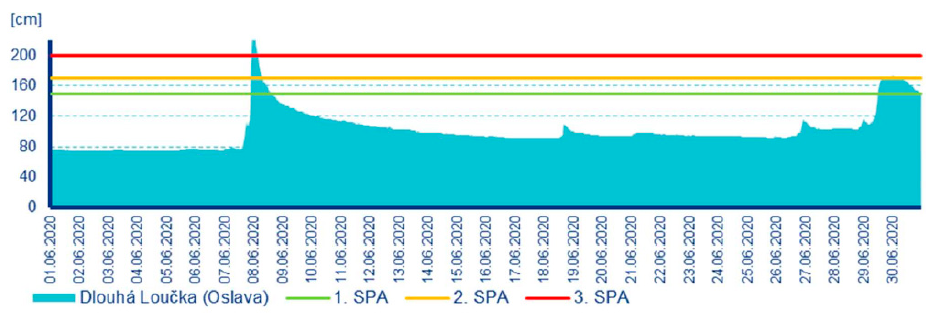
Figure 9. The water level at the Rattendorf hydrological station on river Gail from 28–31 October 2018. Black lines show the times of Sentinel-1 and Sentinel-2 image acquisition. Source of original image: [31].